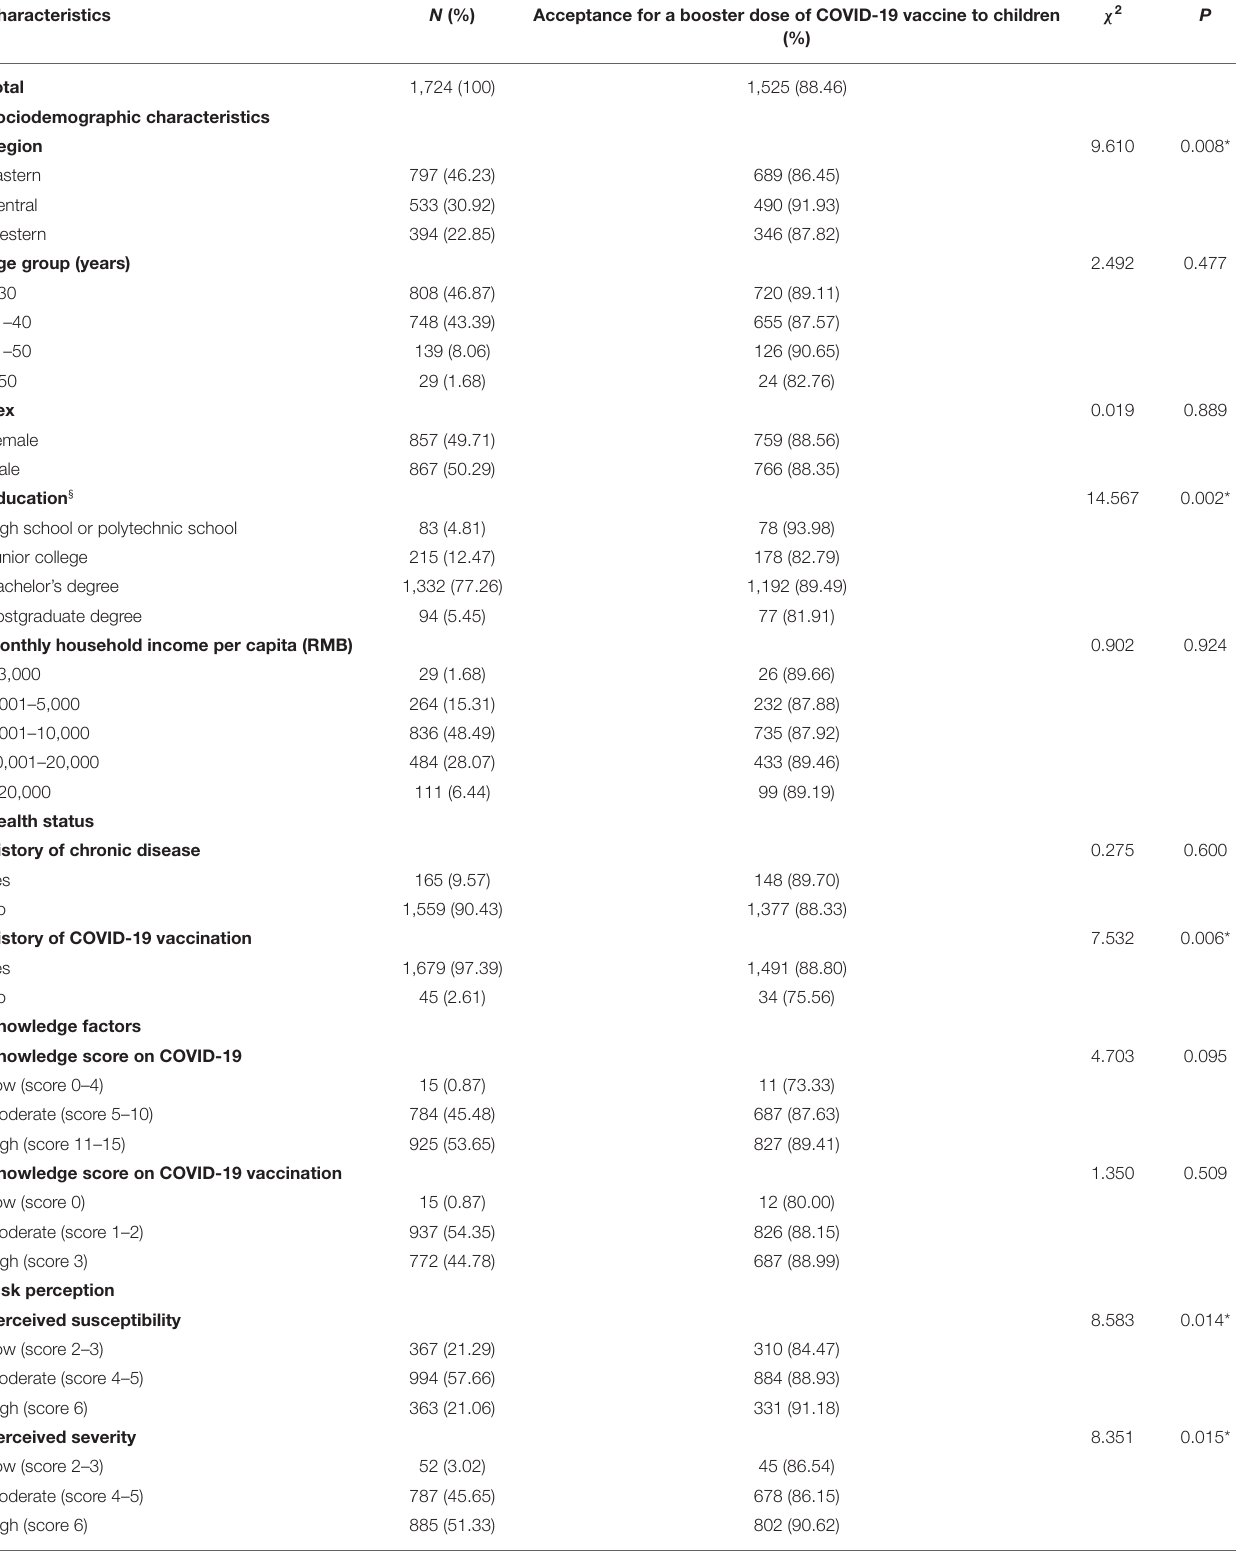
TABLE 1 | Acceptance for a booster dose of COVID-19 vaccine to children among 1,724 child caregivers in China by characteristics.